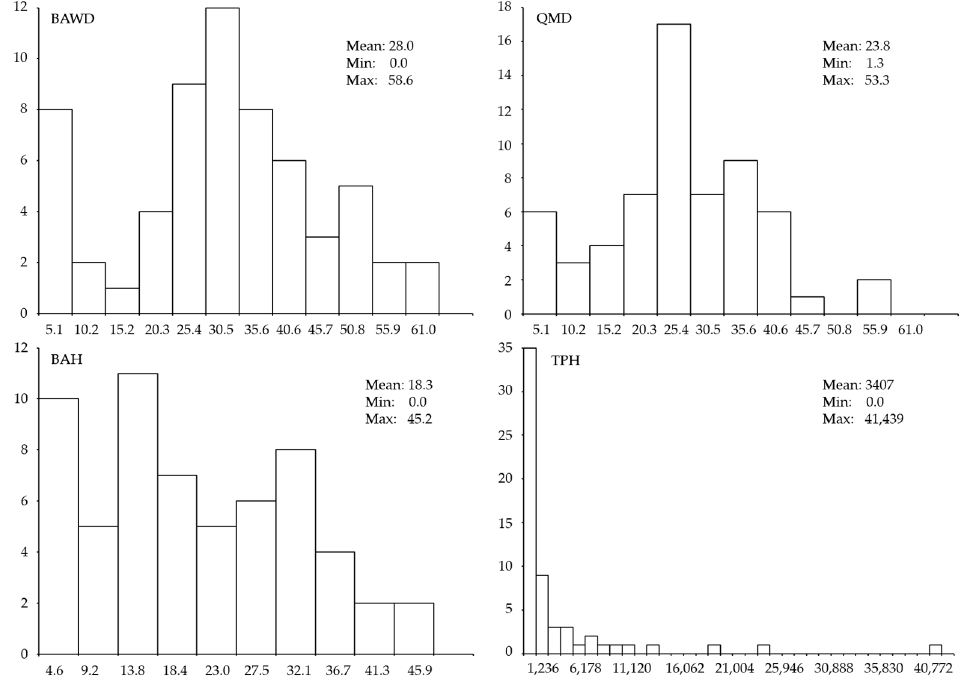
Figure 5. Distribution of basal area weighted diameter (BAWD), quadratic mean diameter (QMD), basal area per hectare (BAH), and trees per hectare (TPH) collected on 60 plots within the study area.